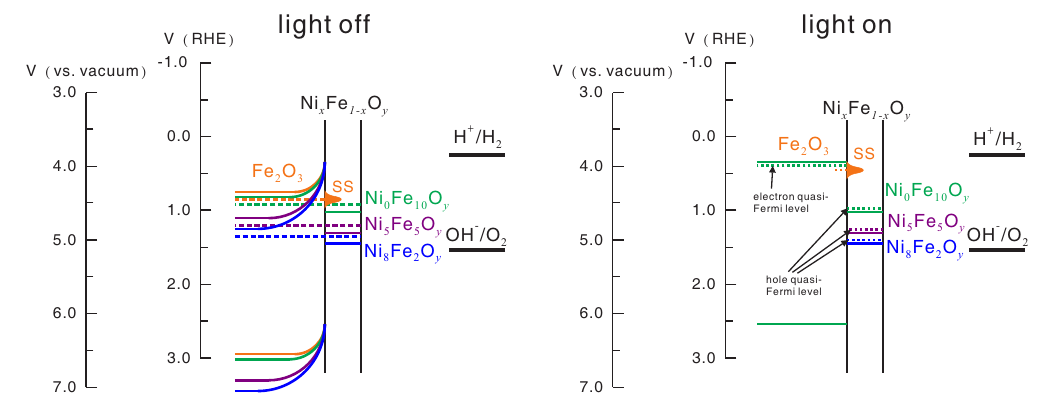
Figure 9. Energy level diagrams of the bare hematite photoanode and the Ni x Fe 1 − x O y /hematite photoanodes with various Ni-to-Fe ratios under open-circuit condition without and with light irradiation. For clarity, only three cases of different Ni-to-Fe ratios are plotted.